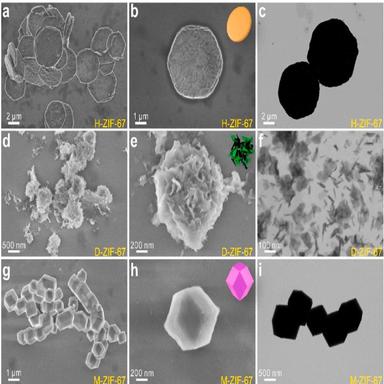
Microstructure of the three ZIF structures obtained using three types of solvent; a, b, d, e, g, and h are SEM images while c, f, and i are TEM results.